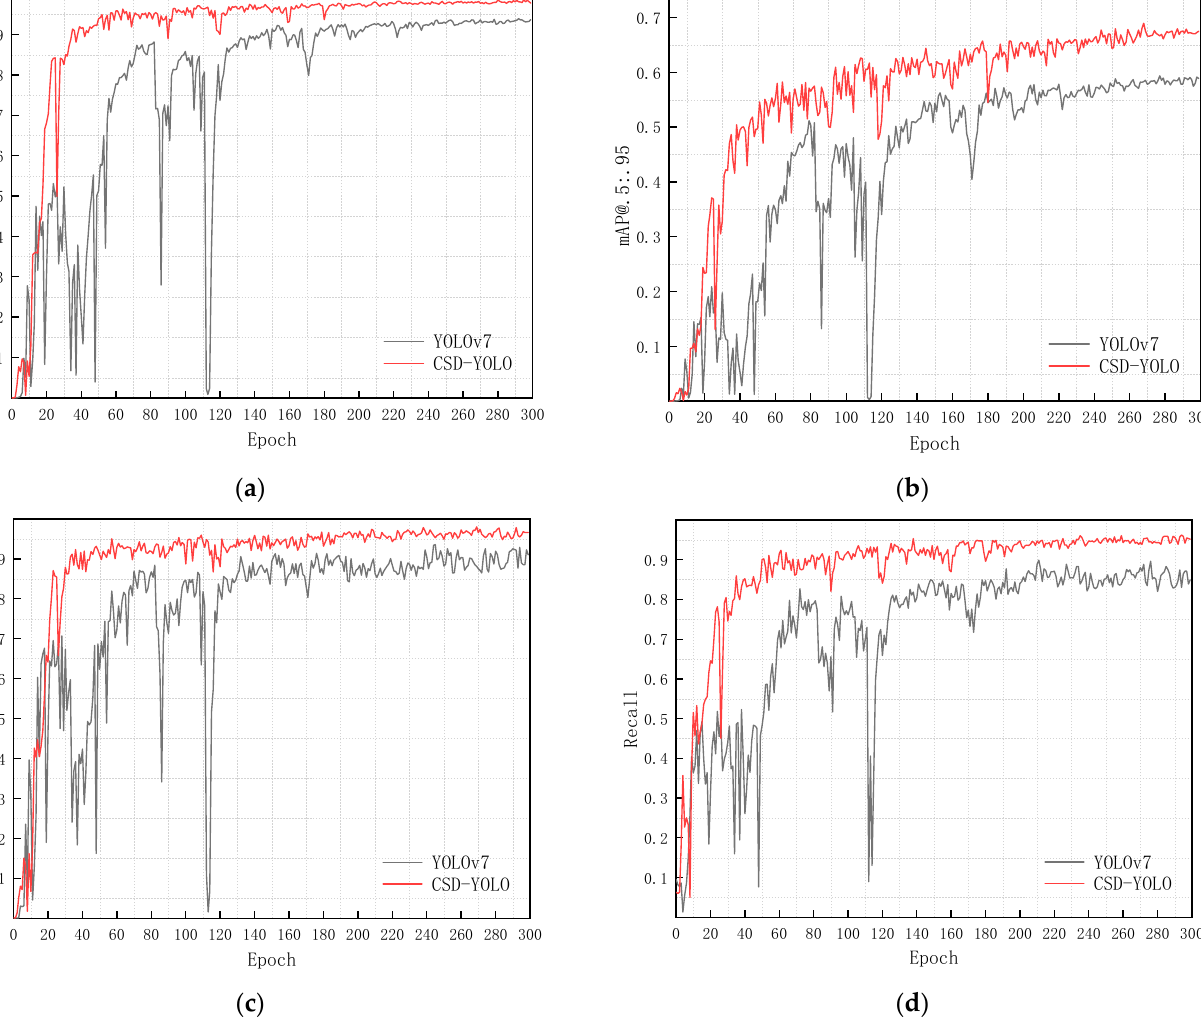
Figure 8. The training process of the two methods (YOLOv7 and the proposed model): ( a ) curve of mAP@0.5, ( b ) curve of mAP@0.5:0.95, ( c ) curve of precision, ( d ) curve of recall. mAP@0.5, ( b ) curve of mAP@0.5:0.95, ( c ) curve of precision, ( d ) curve of